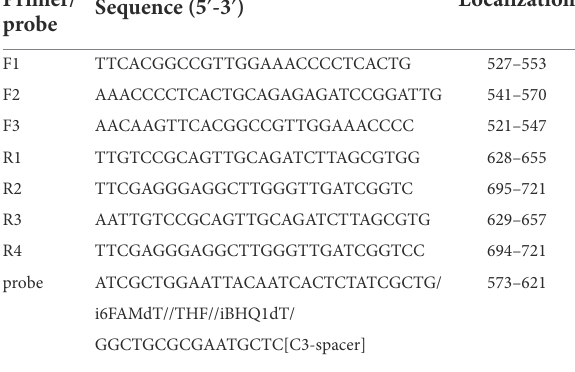
TABLE 2 Real-time RAA assays of primers and probes for